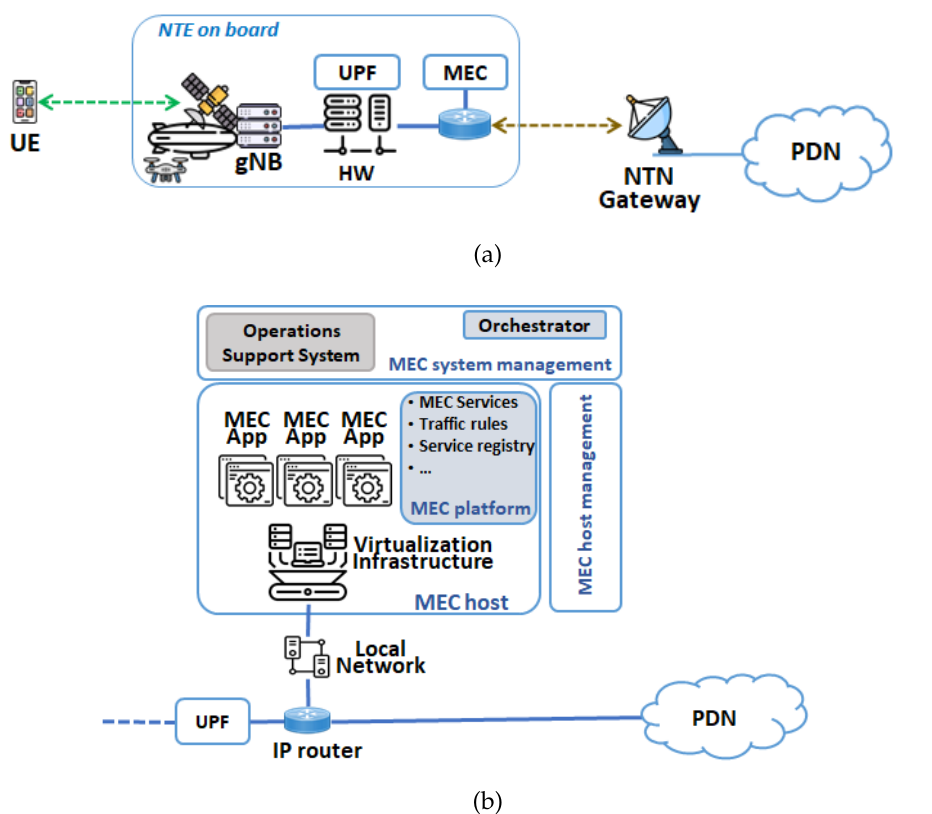
Figure 13. Structure of the multi-access edge computing: ( a ) on-board deployment; ( b )